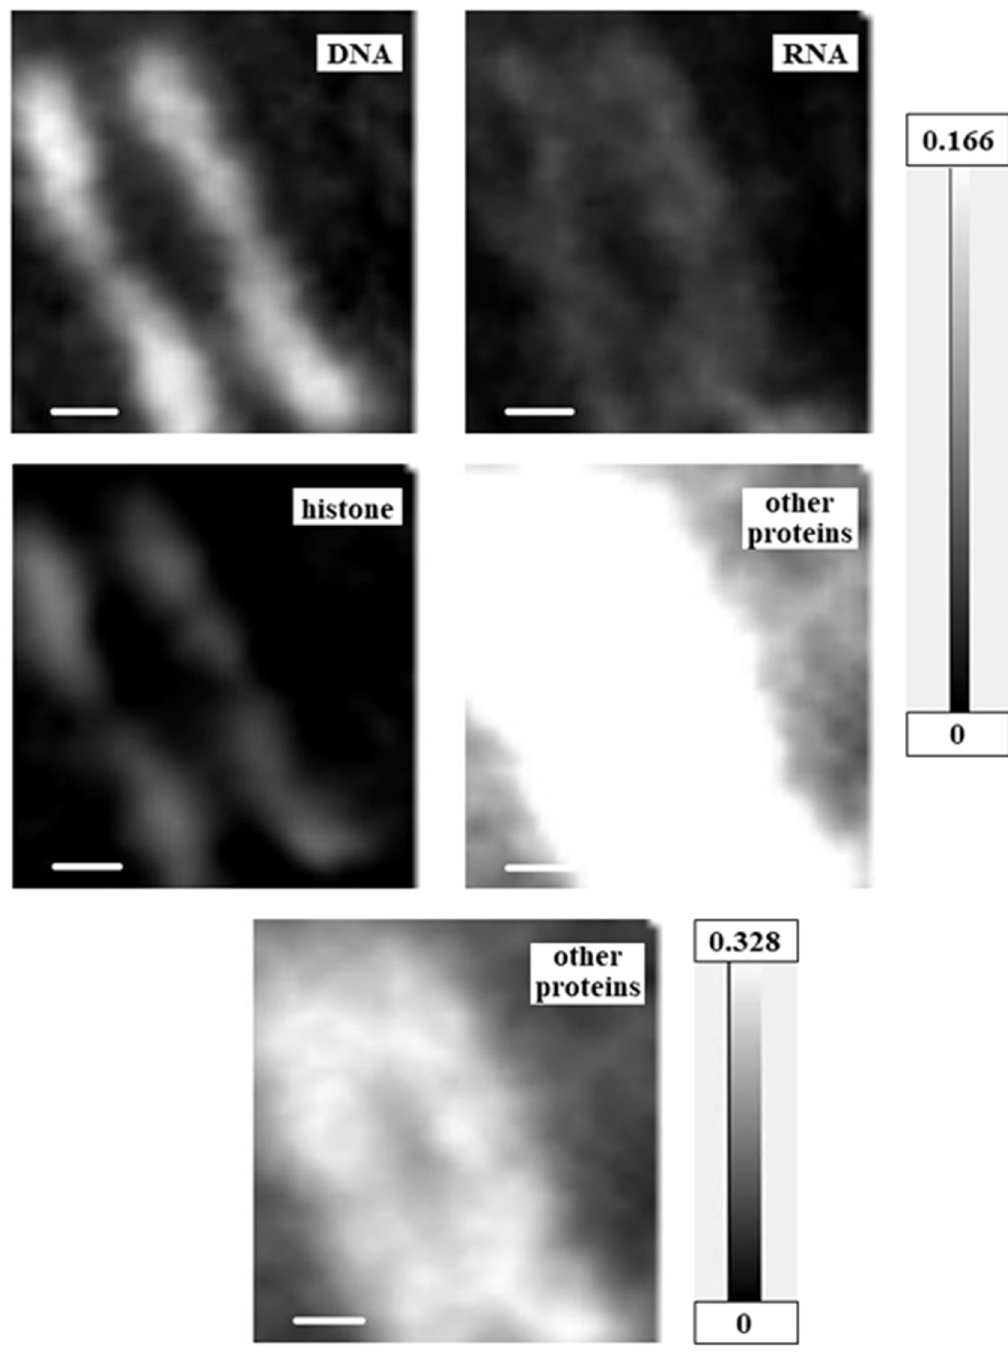
Figure 6. Mass thickness images for DNA, RNA, histone, and proteins other than histone of the chromosome. Grayscales on the right represent units of pg/μm 2 —scale is consistent for the top four images, and different for the bottom image to show the distribution of other proteins more clearly. Scale bars represent 0.5 μm.